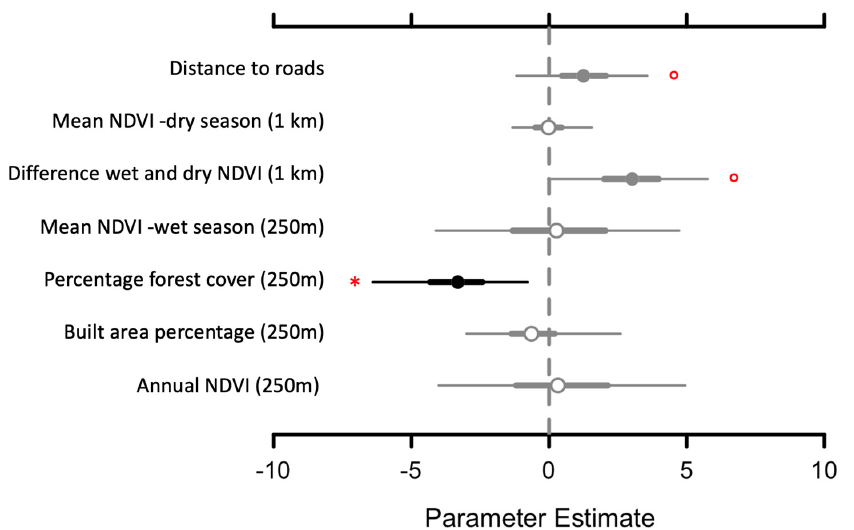
Figure 4. Estimated beta coefficients for the mean occupancy estimation (Posterior means with 95% and 50% Bayesian credible intervals). Black bars and the red star indicate 95% CI no overlapping with zero. Gray bars with closed circles and open red circles indicate 50% CI not overlapping with zero. Gray bars with open circles indicate that the 50% CI overlapping zero.